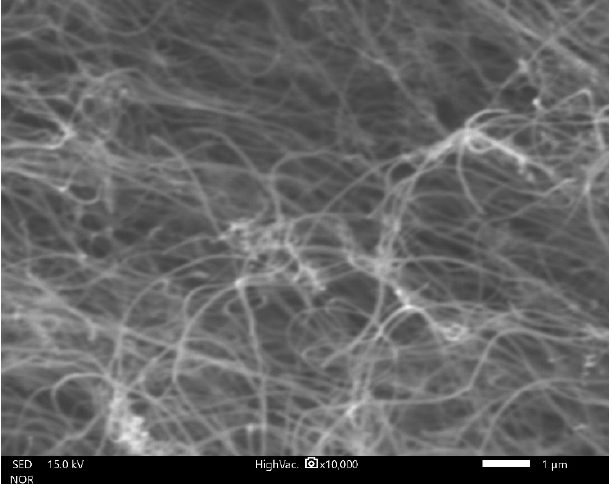
Figure 4. SEM image of carbon nanotubes on Si wafer, after dispersion in CHCl 3 (90